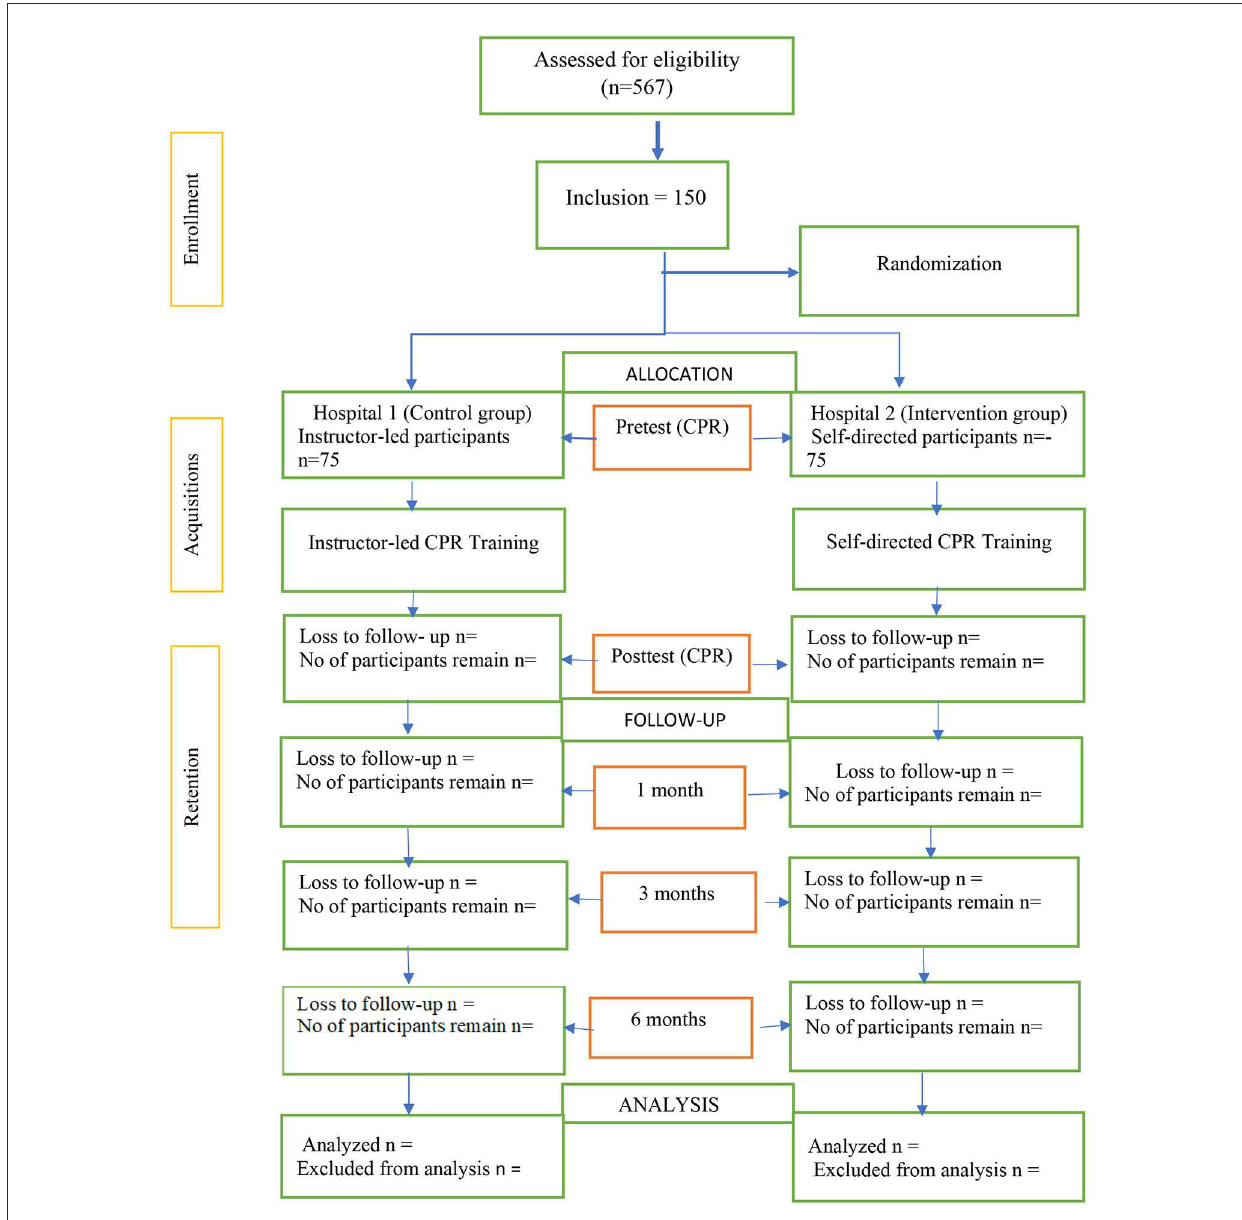
FIGURE1 Flow-chart. Flow chart according to CONSORT (www.consort-statement.org) to compare the effectiveness of CPR/BLS training between video self-instructor and instructor-led